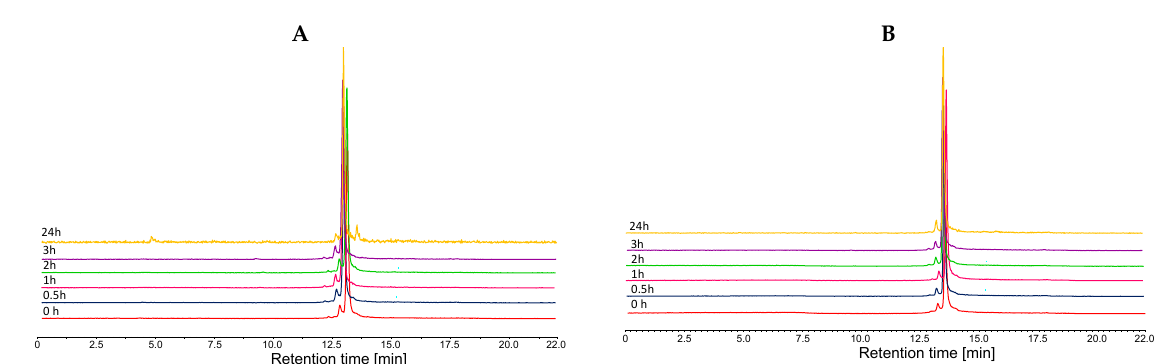
Figure 1. Stability of [ 99m Tc]Tc-TECANT-1 ( A ) and [ 99m Tc]Tc-TECANT-2 ( B ) in human serum at 37 °C after an incubation of 0, 30, 60, 120, 240 min, and 24 h.